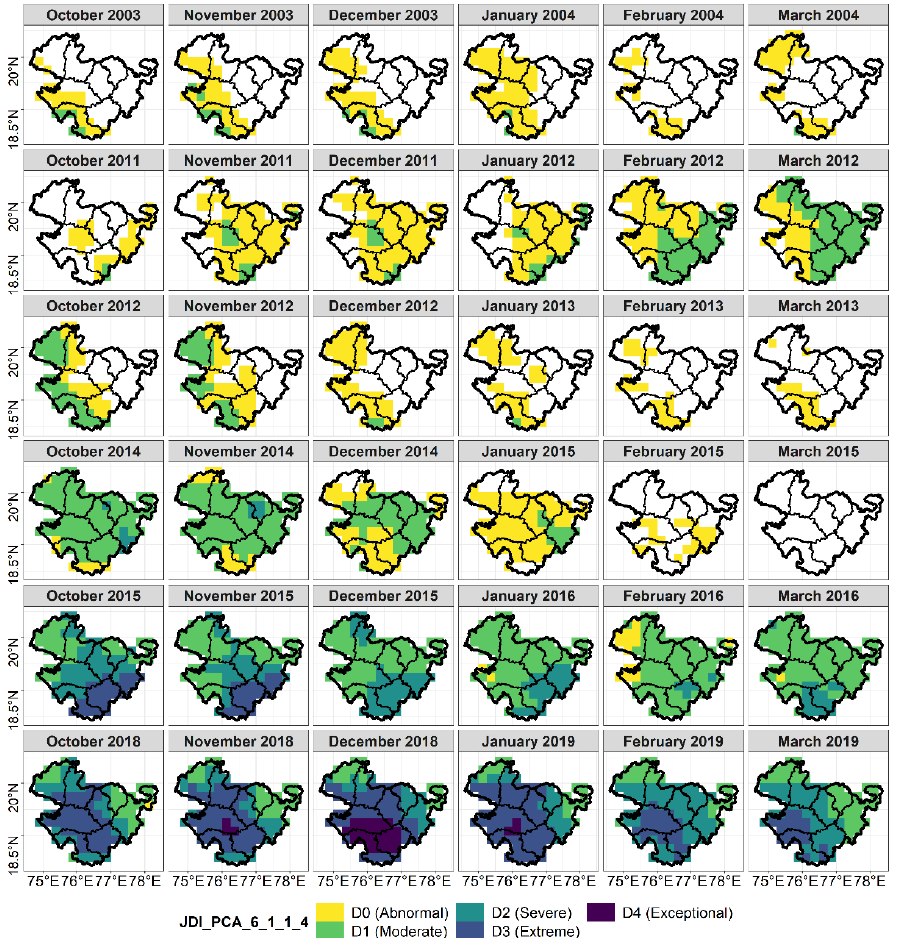
Figure 8. Spatial distribution of drought severity in Rabi season of different drought years detected by using JDI_PCA.